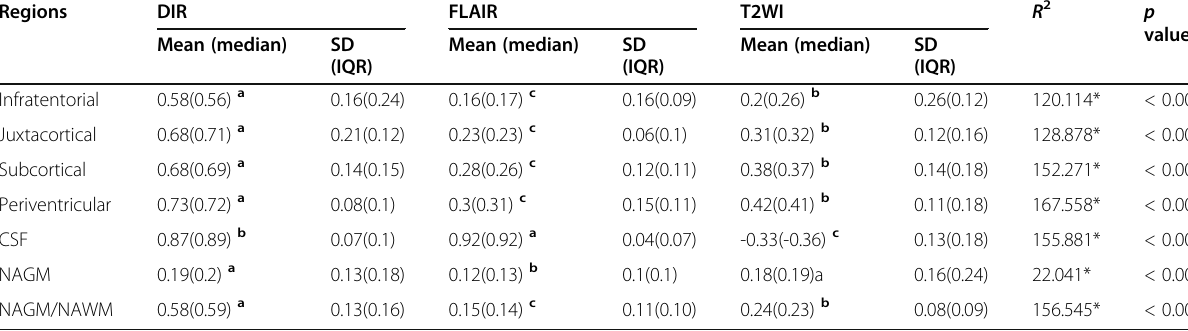
Table 3 Comparison of Image Contrast based on regions among DIR, FLAIR, and T2WI Regions DIR FLAIR